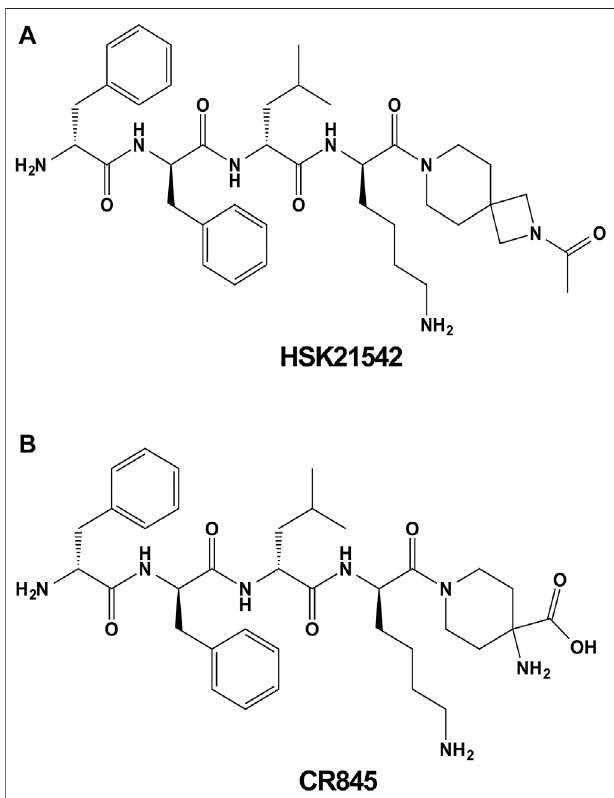
FIGURE 1 | Chemical structures of HSK21542 (A) and CR845 (B)